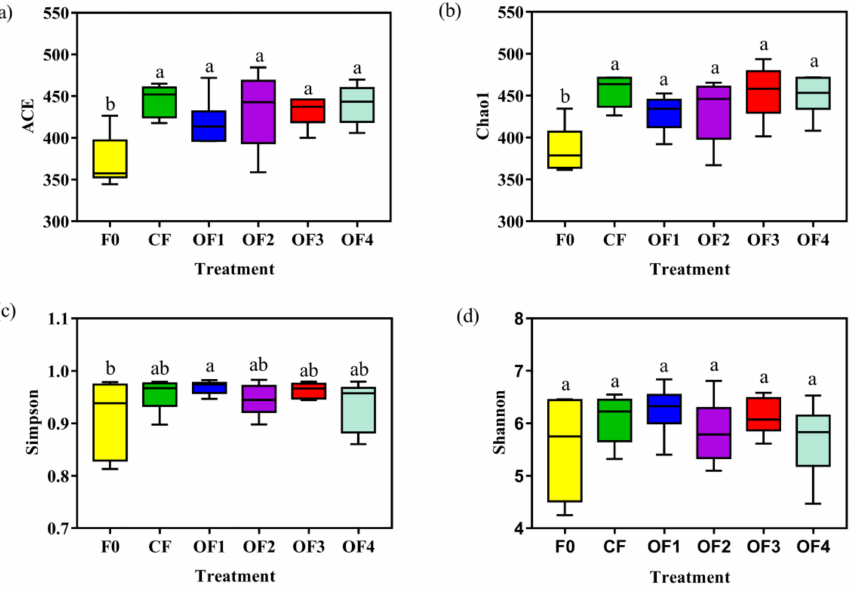
Figure 2. Alpha diversity ( a , ACE index; b , Chao1 index; c , Simpson index; and d , Shannon